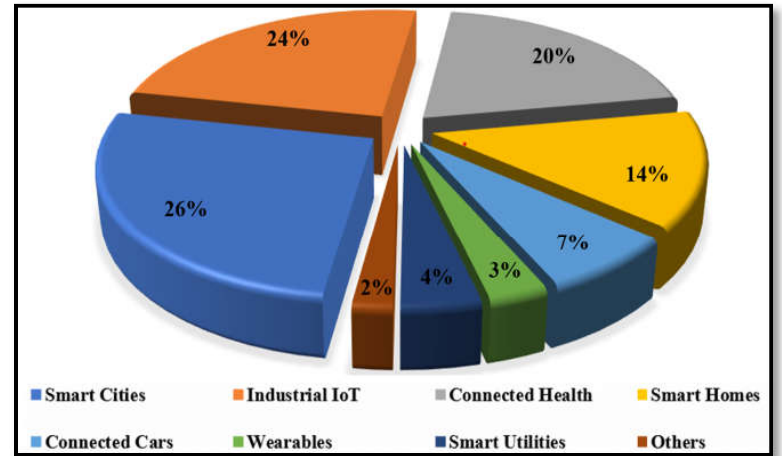
Figure 7. General market structure of IoT technologies [151].